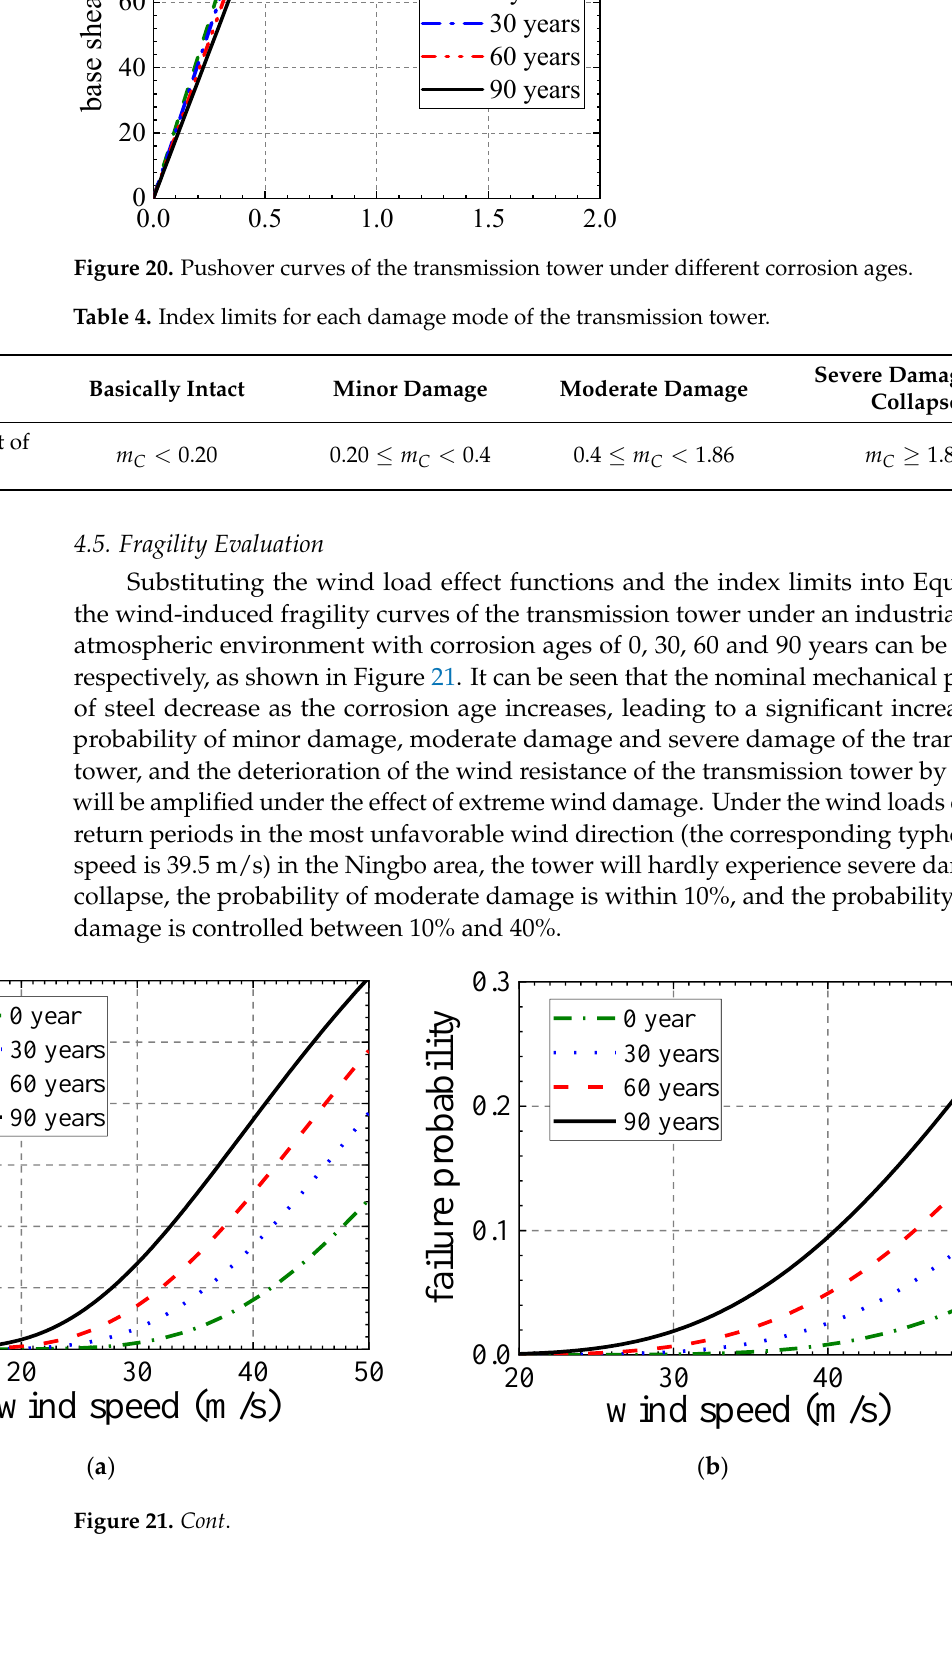
( c ) Figure 21. Wind-induced fragility curves of the transmission tower with different corrosion ages under the industrial-marine atmospheric environment in the Ningbo area. ( a ) Minor damage. ( b ) moderate damage and ( c ) severe damage and collapse. 5. Conclusions In this paper, a long-term corrosion depth prediction model for carbon steel applica- ble of the Ningbo area was established, a mixed climate multi-wind direction extreme wind speed estimation method was developed and wind-induced fragility curves for the transmission tower under different corrosion ages were obtained, which can be used to quantitatively evaluate the effect of long-term corrosion on the deterioration of wind re- sistance of a steel transmission tower during its service life. The specific findings are as follows: (1) The corrosion rates of carbon steel in different atmospheric environments in the Ningbo area are in descending order: industrial – marine (I – M) atmosphere, marine (M) atmosphere, urban/industrial (U/I) atmosphere and rural (R) atmosphere. Among them, the corrosion depth of carbon steel exceeds 1600 μm under the 100-year corrosion age of the I – M atmospheric environment, which indicates that, in such an atmospheric environ- ment, transmission towers are the most vulnerable to corrosion; (2) The wind climate in the Ningbo area is mainly controlled by typhoons, and the design wind speed given by the current load code is on the risky side;